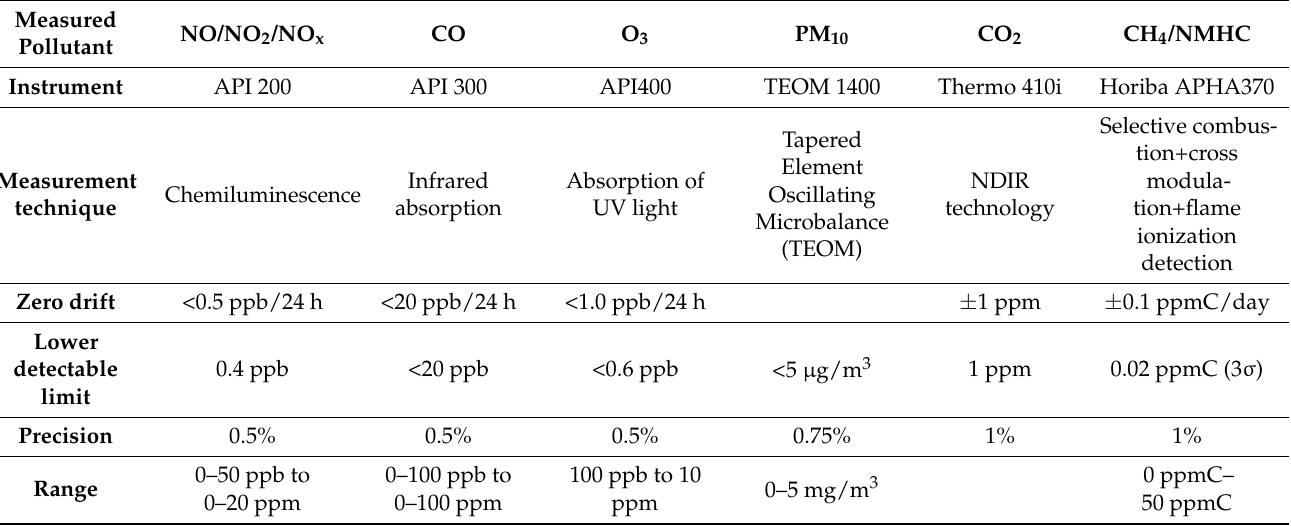
Table A1. Technical specifications of instruments employed during measuring